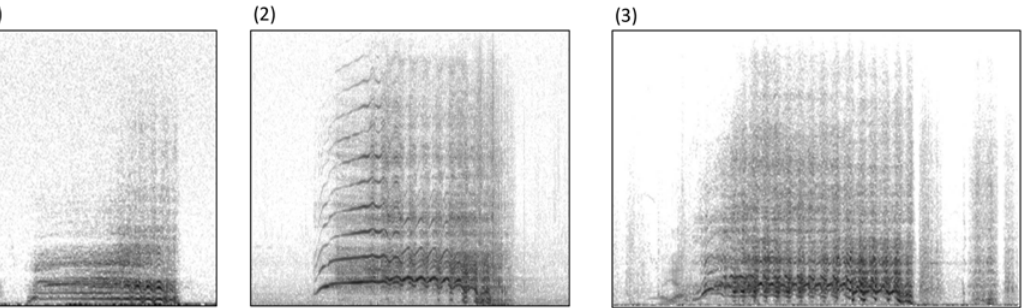
Fig 3. Heart beat rates in relation to number of repeated units in the climax of the whinny. Example of three spectrograms (X axis = duration, Y axis = frequency): (1) NBU2 = 4 — HB5s = 174 beats per minute (bpm), (2) NBU2 = 8 — HB5s = 112 bpm, (3) NBU2 = 15 — HB5s = 73